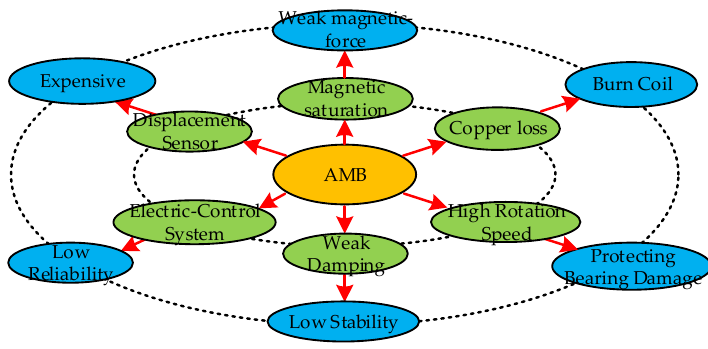
Figure 1. Faults of active electromagnetic bearing (AMB ) .